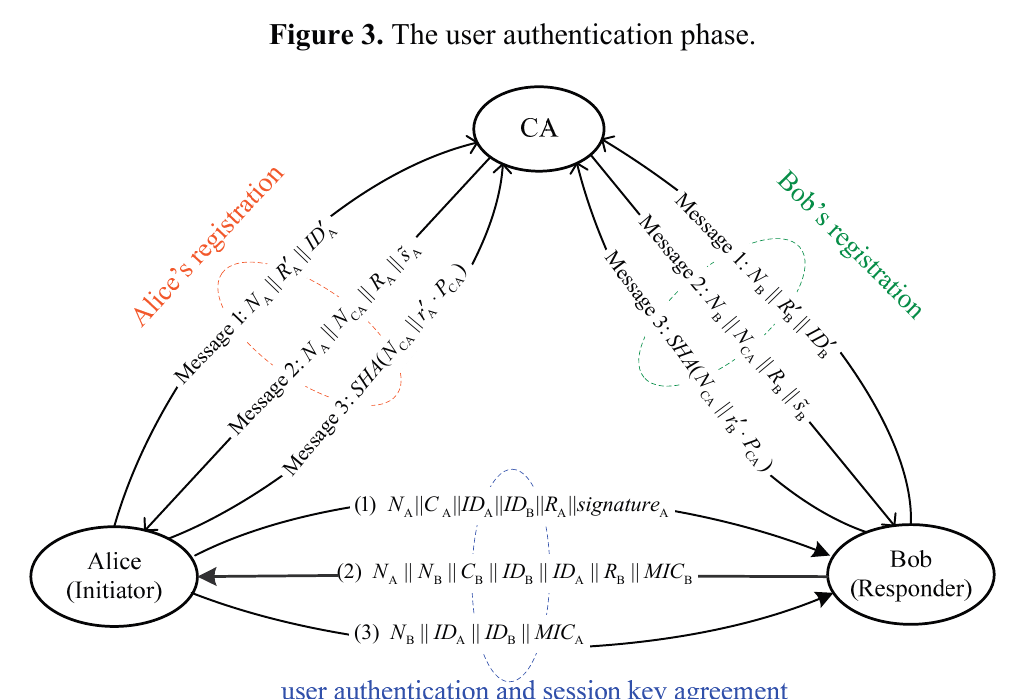
Figure 3. The user authentication phase.